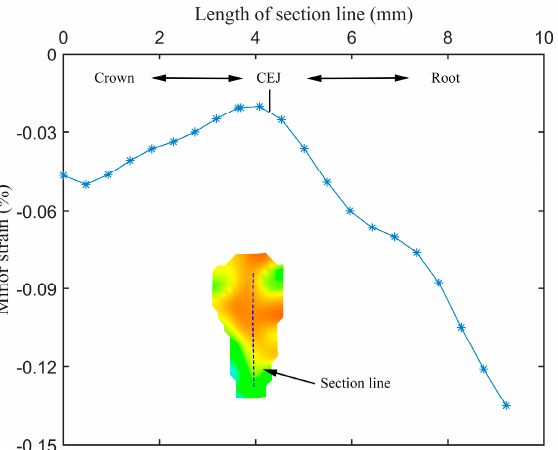
Figure 7. The orientation distributions of the minor strains of ( a ) another specimen at ( b ) stage 15 and ( c ) stage 30. The purple dotted lines denote the CEJ. It can be seen that the watershed exists in both the orientation field and the value field of minor strains.